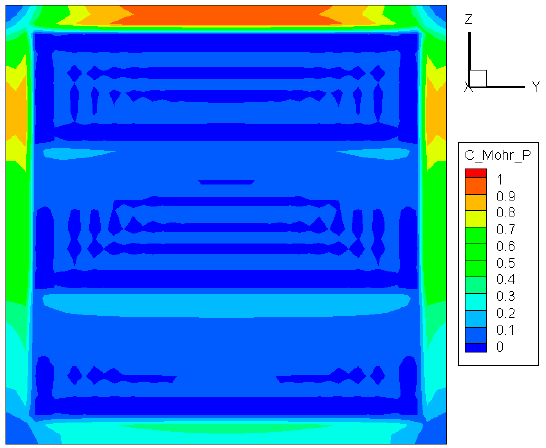
/),,max( S  before crack initiation. Figure 5. Distribution of max ( σ ) / S ut before crack ut321 1 , σ 2 , σ 3